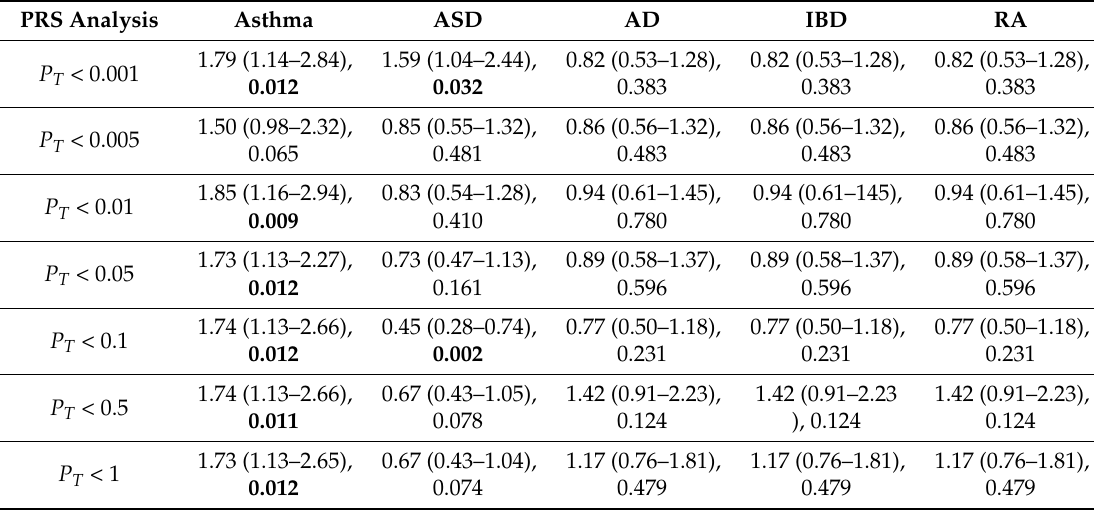
Table 2. Odds ratios polygenic risk score (PRS)